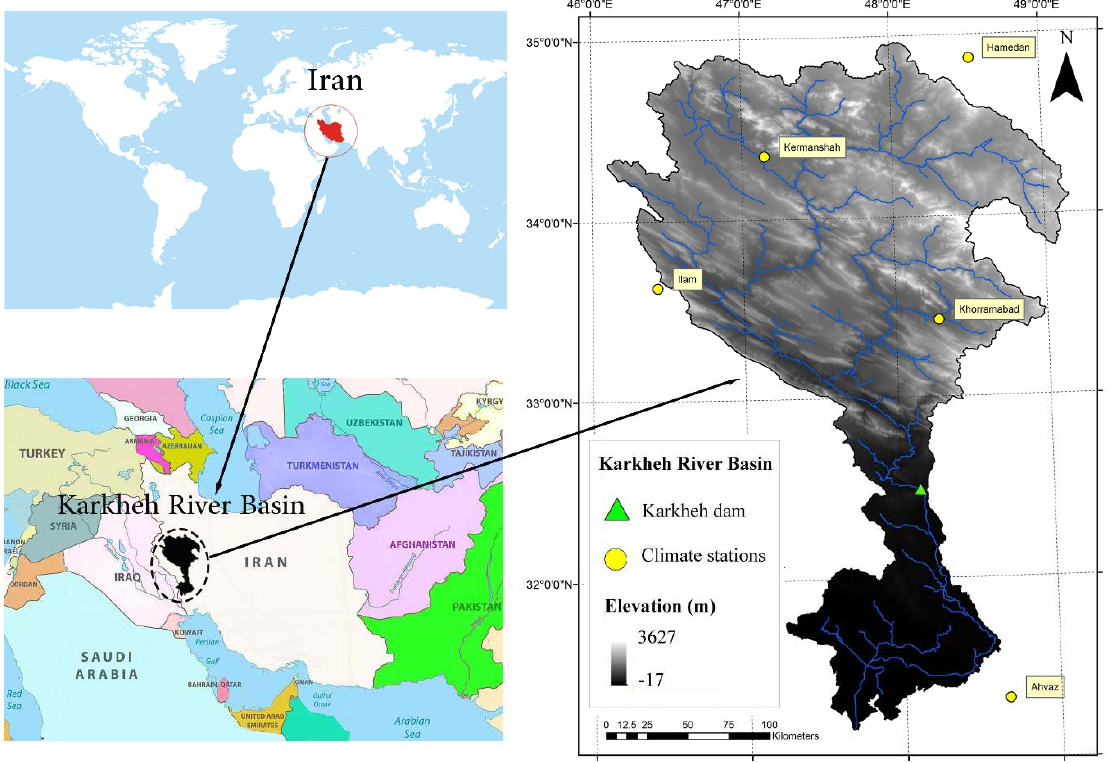
Figure 1. Map of the Karkheh river basin with weather stations and the Karkheh dam.